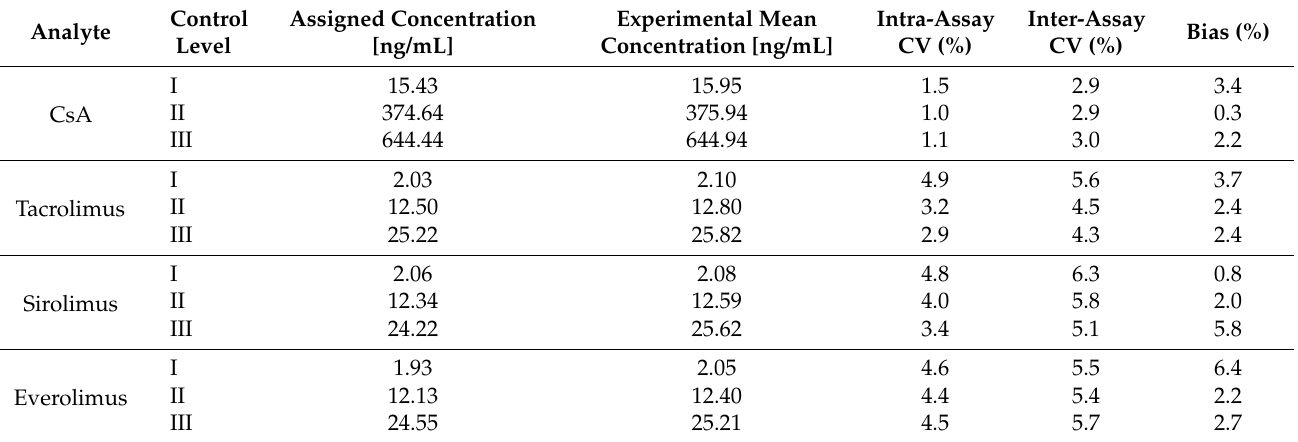
Table 5. Intra- and inter-assay precision and accuracy (given as bias %) regarding Cascadion analysis are shown for each control level